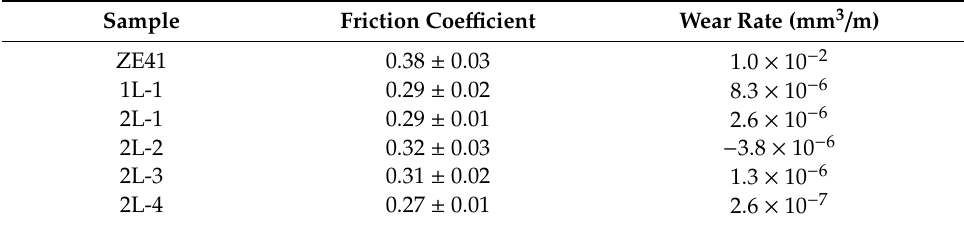
Table 4. Results summary of the tribological performance of each specimen.